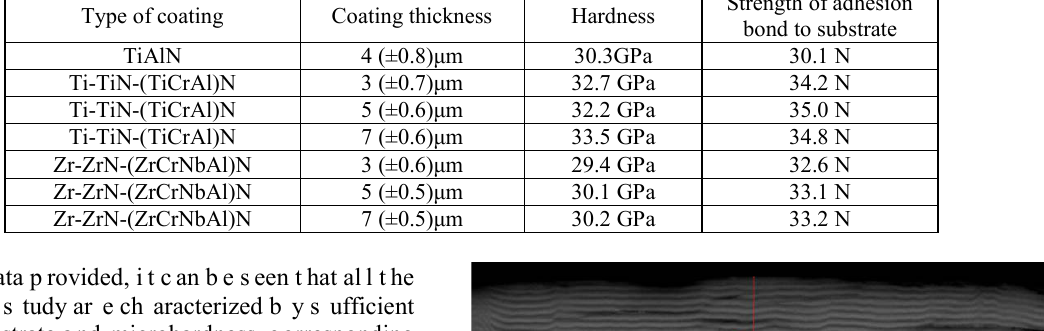
Strength of adhesion bond to substrate